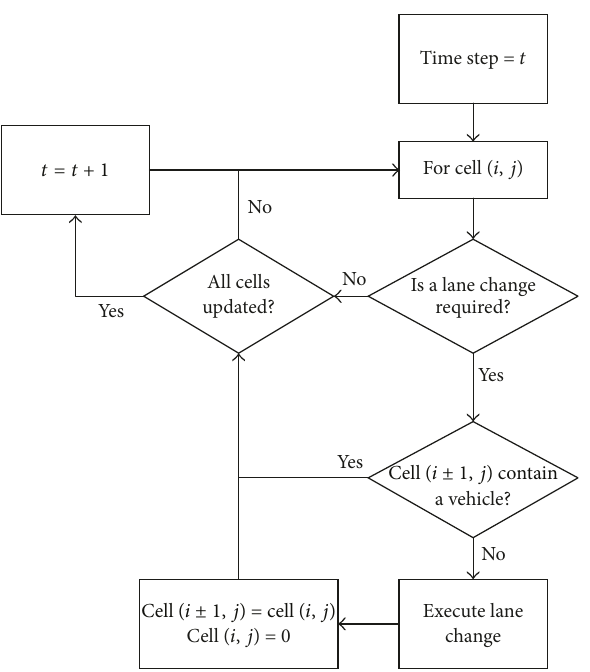
Figure 4: Algorithm for mandatory lane